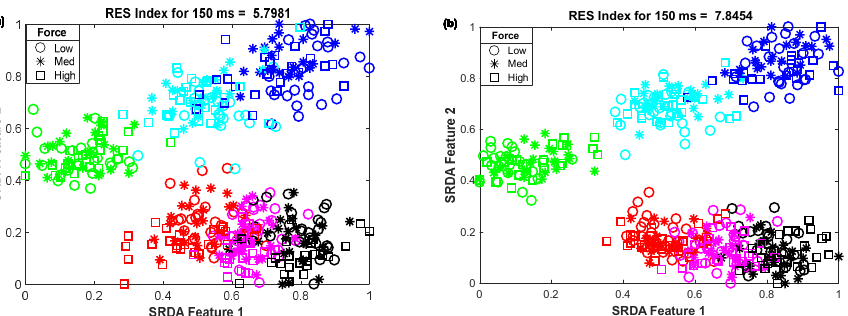
Figure 4. The impact of the nonlinear transformation of seven features on a 2D-feature space: ( a ) original feature space and ( b ) nonlinearly transformed feature space.